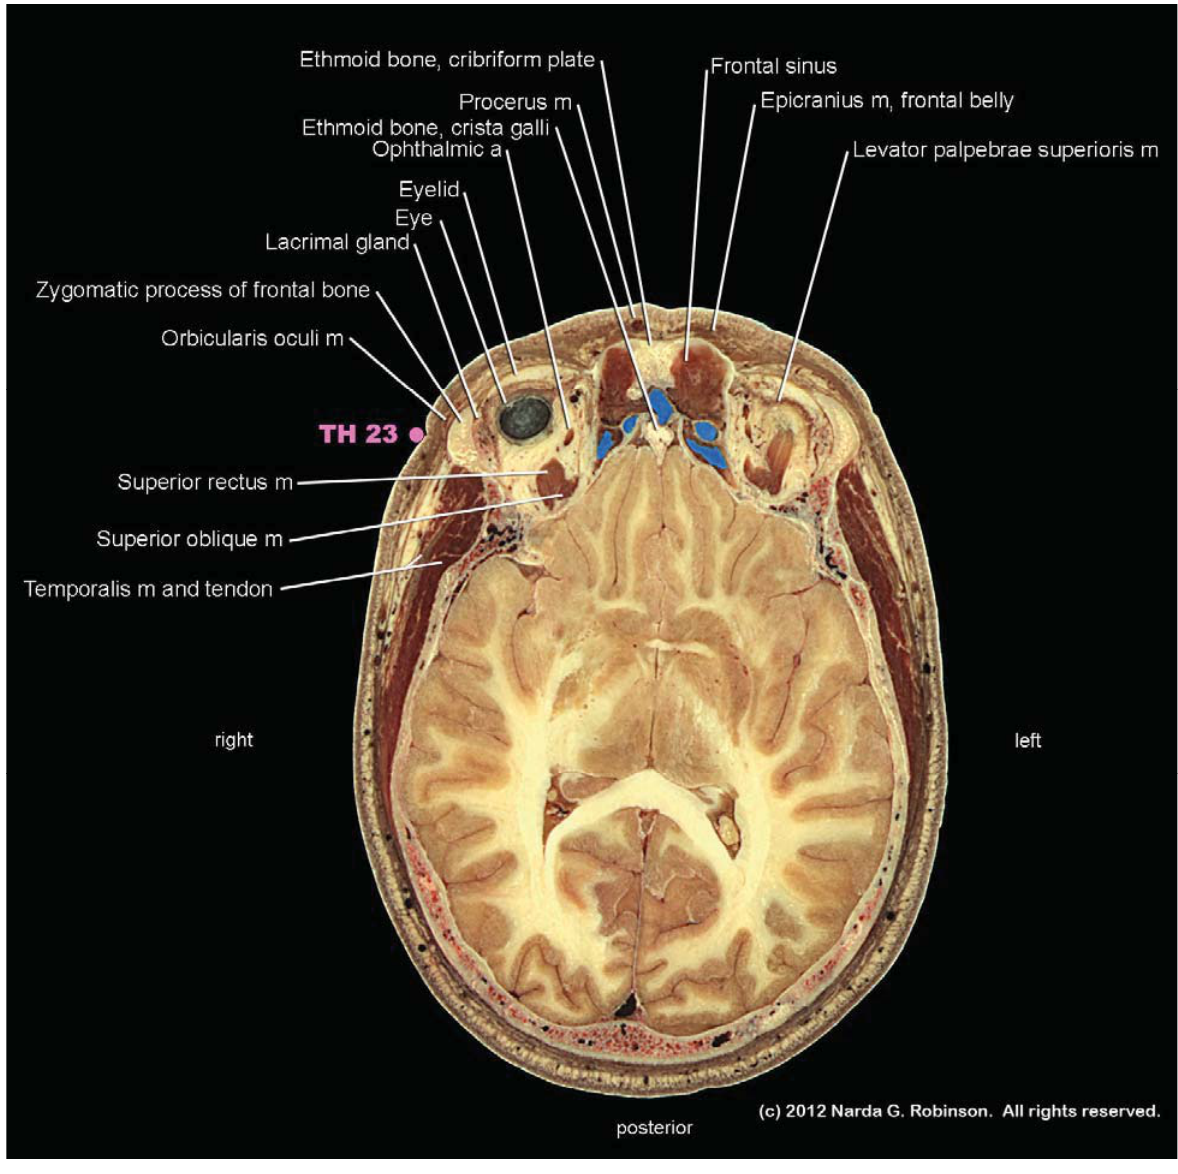
Figure 2. This cross section demonstrates the relationship of acupuncture point TH 23 to the zygomatic process of the frontal bone and the overlying thin layer of orbicularis oculi muscle. The clinical significance of this anatomy pertains to translational safety issues in acupuncture. That is, a human acupuncturist expects to reach bone shortly after penetrating the soft tissues. In contrast, the bony orbit in the dog ends at this site. A needle entering the soft tissue could therefore enter the orbit. (Image courtesy of Narda G. Robinson, DO, DVM, MS and Teton NewMedia. From